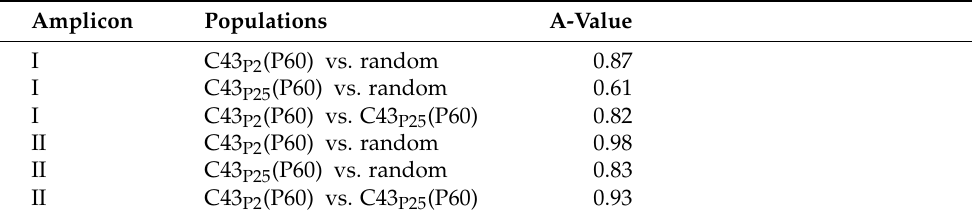
Table 2. Vargha and Delaney’s A-values for pairwise comparisons of distributions of changes in protein folding energy. An A-value of 0.5 indicates that there is no significant